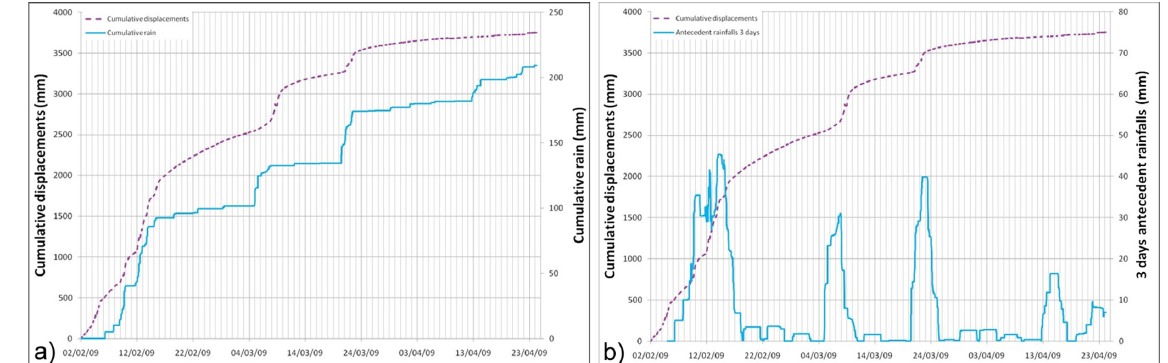
Fig. 11. (a) Comparison between the cumulative displacements of point P6 and cumulative rain values; (b) comparison between the cumu- lative displacements of point P6 and 3 days antecedent rainfall.